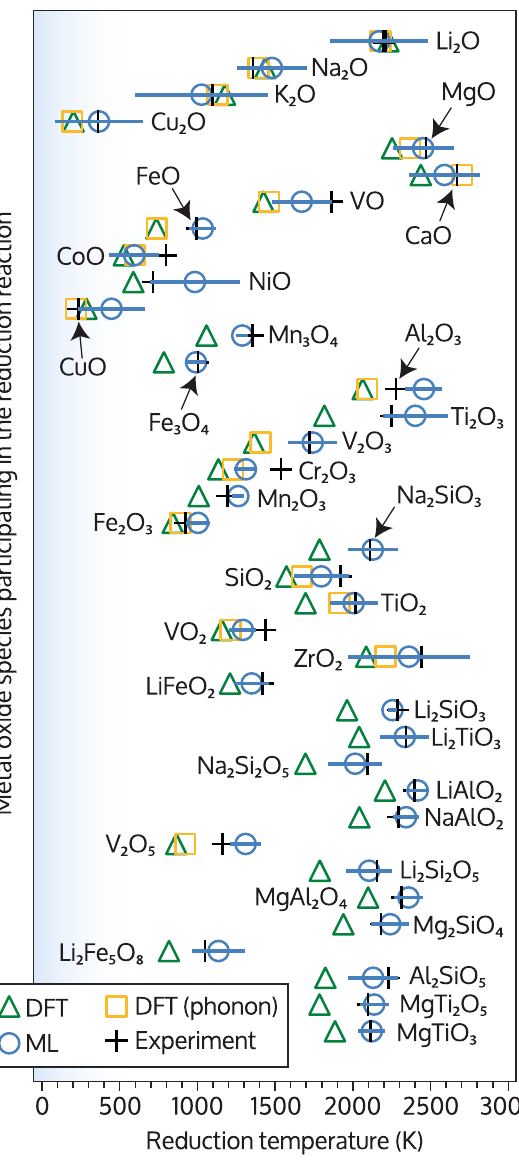
Fig. 2 Comparison of predicted and reference metal oxide reduction temperatures. Green triangles indicate the oxide reduction temperatures as predicted by density-functional theory (DFT) calculations only considering the temperature-dependent entropy contributions of CO. The orange squares show the reduction temperatures after correcting the DFT calculations using phonon theory. The predictions obtained from our machine learning (ML) model trained on reduction temperatures are indicated by blue circles. These data points were obtained from leave-one- out cross-validation and are thus pure predictions and were not included in the model construction. The horizontal error bars indicate the uncertainty estimates from the Gaussian process regression model. The black crosses indicate the experimental reference values of Supplementary Table 1. See Supplementary Fig. 1 for correlation plots of the predicted temperatures with the reference values. All data can be found in Supplementary Table